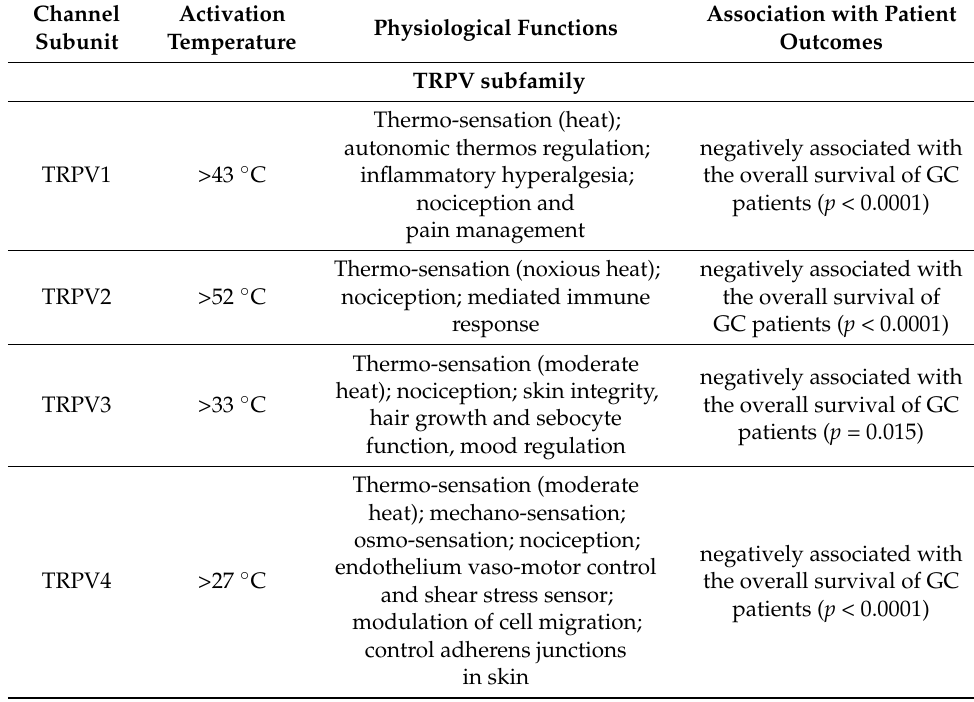
Figure 1. The activation of thermo-TRPs by specified temperature and particular compounds. Thermo-TRPs are expressed in diverse cell lines and are activated by ambient changes. TRPA1 is activated by noxious cold ( ≤ 17 ◦ C). TRPM8, TRPM5, TRPC5, TRPV4, TRPM3, and TRPM2 are activated by innocuous warm and cool stimuli (ranges from 15–35 ◦ C). Whereas TRPM4, TRPV1, and TRPV2 are activated by heat in the noxious range, with respective thresholds of 40 ◦ C, 42 ◦ C, and 52 ◦ C. Moreover, all thermo-TRPs can also be activated by various agonists present in the environment. Thermo-TRPs, thermo-sensitive transient receptor potential channels. Table 1. Different members of the Thermo-TRP and their main characteristics.